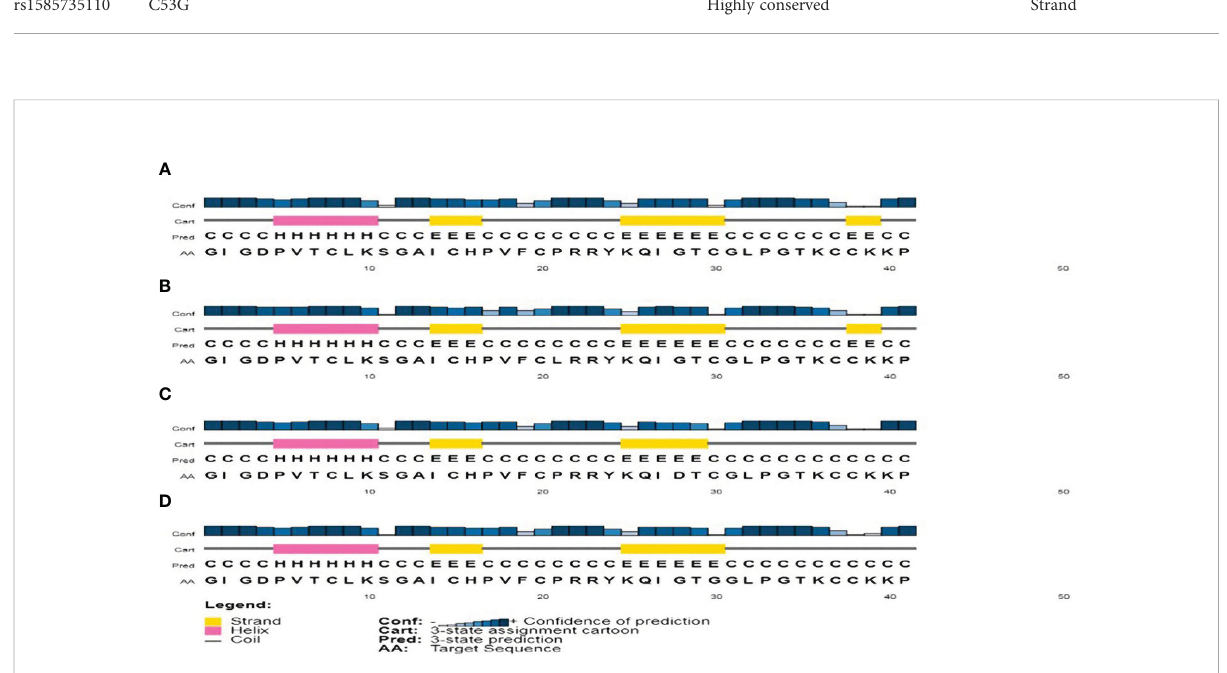
FIGURE 1 The analysis of secondary structure as produced by the PSIPRED tool. (A) The analysis of the secondary structure of h BD-2 (wild type). (B) The analysis of the secondary structure of h BD-2 with P44L SNP. (C) The analysis of the secondary structure of h BD-2 with G51D SNP. (D) The analysis of the secondary structure of h BD-2 with C53G SNP.